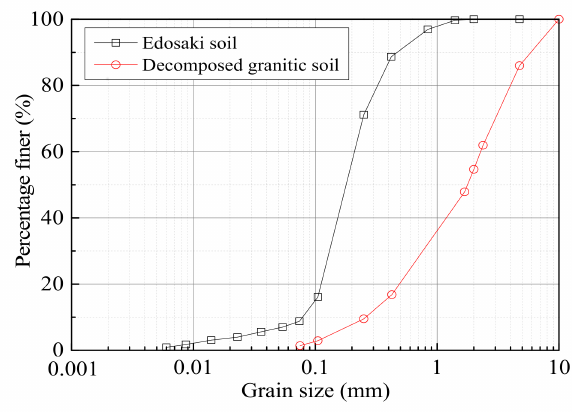
Figure 1. Grading curves of Edosaki and decomposed granitic